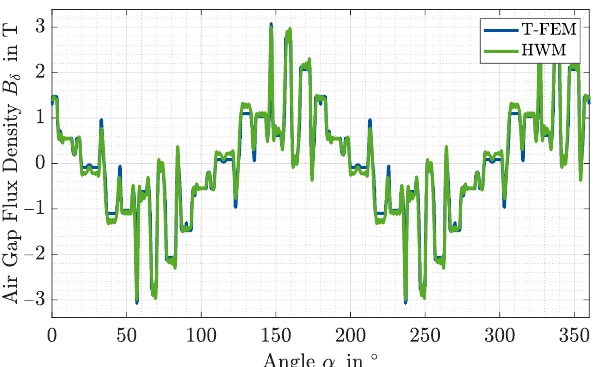
Figure 3. Simulated air gap flux density of an IM with linear stator and rotor magnetic material properties using the T-FEM and